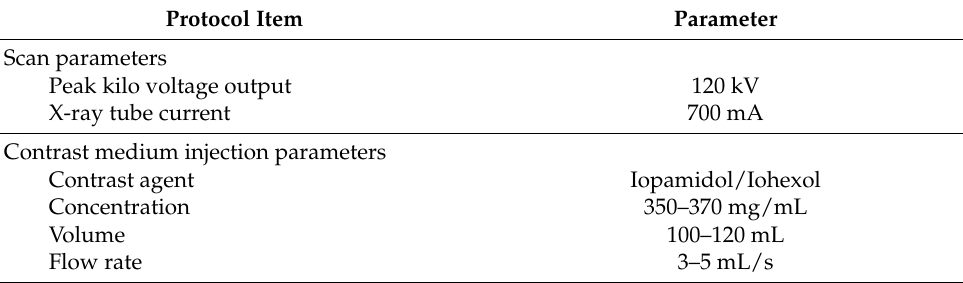
Table 2. Image acquisition protocol of MDCT examinations.